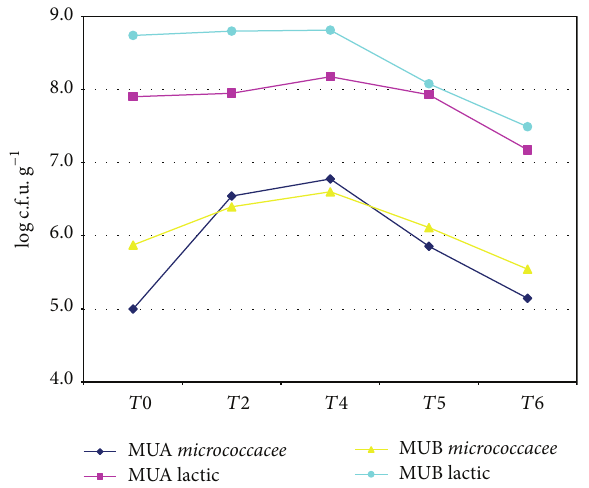
Figure 1: Evolution of Micrococcaceae and lactic acid bacteria dur- ing ripening of Muletta salami (log c.f.u. g −1